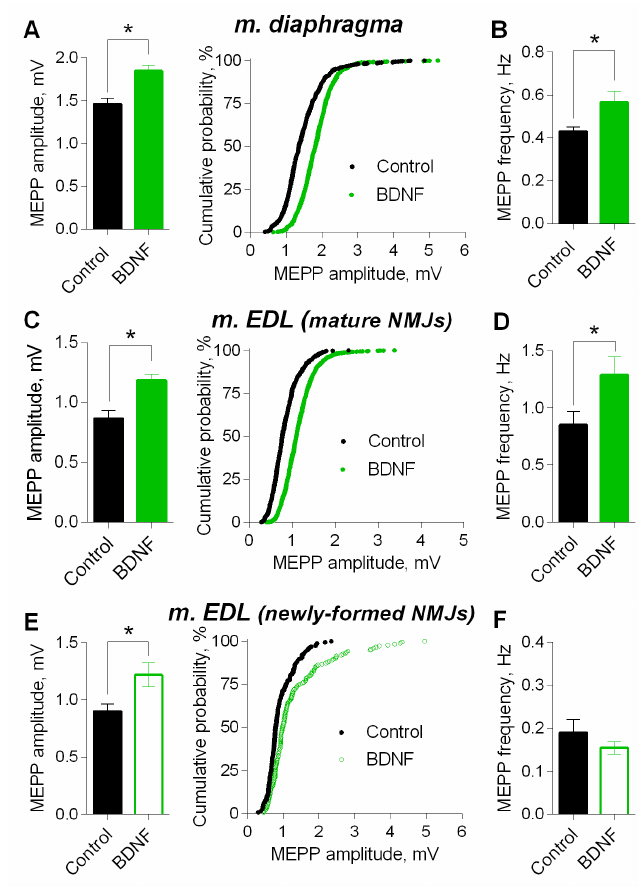
Figure 7. BDNF (1 nM) potentiates spontaneous ACh release at mouse NMJs. ( A ) Mean amplitude of MEPPs (left) and cumulative probability plots (right) in control ( n = 21) and upon application of BDNF ( n = 22) at diaphragm NMJs. ( B ) Mean frequency of MEPPs in control and in the presence of BDNF a diaphragm NMJs. ( C ) Mean amplitude of MEPPs (left) and cumulative probability plots (right) in control ( n = 15) and upon application of BDNF ( n = 21) at mature NMJs in m. EDL. ( D ) Mean frequency of MEPPs in control and after BDNF was applied at mature NMJs in m. EDL. ( E ) Mean amplitude of MEPPs (left) and cumulative probability plots (right) in control ( n = 15) and upon application of BDNF ( n = 19) at newly-formed NMJs in reinnervated m. EDL. ( F ) Mean frequency of MEPPs in control and after BDNF was applied at newly-formed NMJs in reinnervated m. EDL. Histograms and error bars represent the mean ± SEM. * p < 0.05 compared to control .